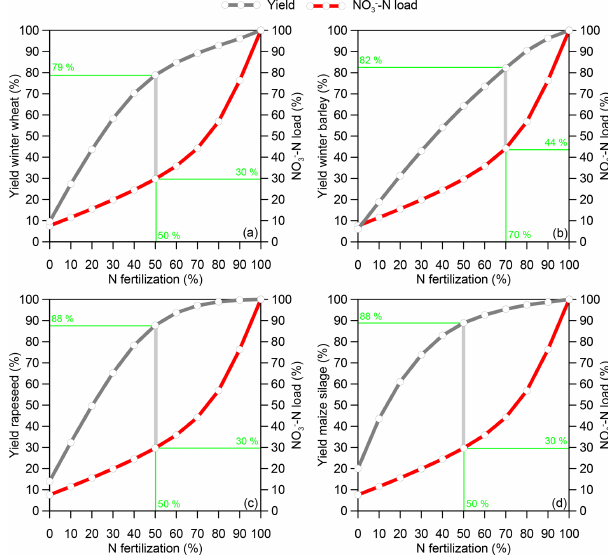
Figure 7. Relationships between measured and simulated crop yields for winter wheat, winter barley, rapeseed, and maize silage.